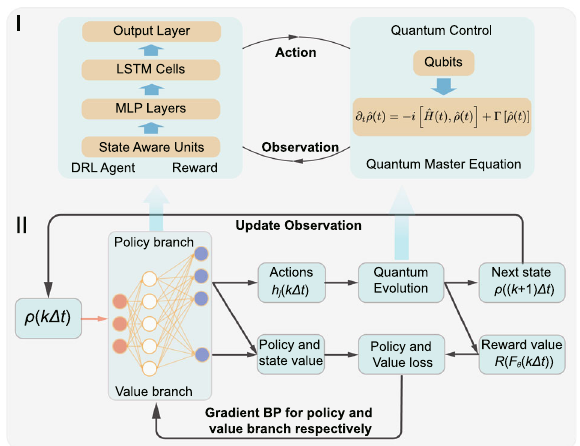
Fig. 3 Illustration of DRL with (I) agent-environment interaction (II) state-aware policy and value networks with LSTMCells 57 for quantum sensing protocols. Generally, the quantum evolution can be characterized by quantum master equation both for pure and mixed states. The joint network is divided into the policy/value branch at the fi nal neural layer. The policy and value gradient are updated to the policy and value branch, respectively. The reward R is a function of the QFI (given by the quantum evolution) which can be calculated by the current control sequence and state. BP refers to